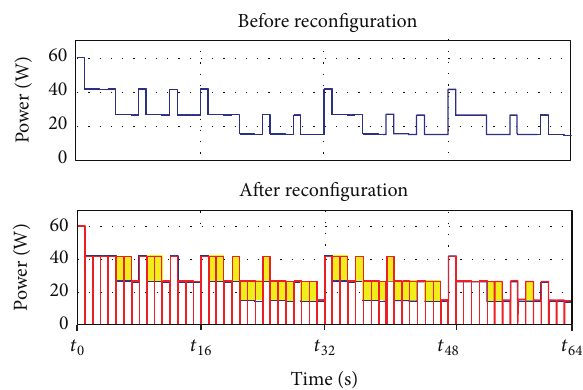
Figure 8: Power versus time curve for a 2 × 2 array and progressive shading (before and after reconfiguration).